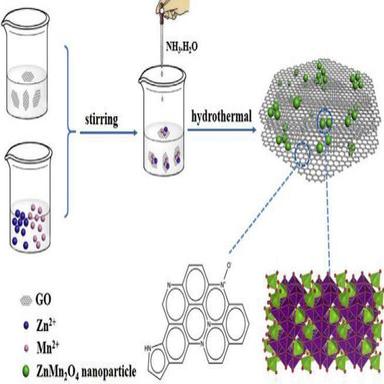
(a) XRD patterns of ZnMn2O4/NG and pure ZnMn2O4. (b) SEM, (c and d) TEM, (e) corresponded particle size distribution and (f) HRTEM images of prepared ZnMn2O4/NG.